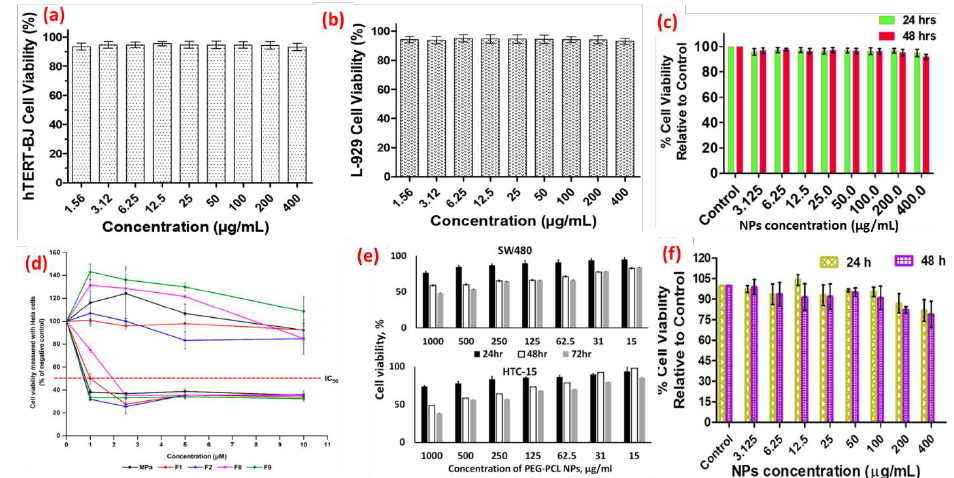
Figure 3. Safety and toxicity assessment of different nanocarriers in vitro. ( a – c ) Assessment of safety and toxicity of blank and drug-loaded chitosan NPs in dose-dependent and time-dependent manner (reproduced from [82] with permission from the American Chemical Society). ( d ) Viability of two cancer cell lines (HeLa and A549) treated with free compound and its loaded nanocarriers, F1, F2, F8, and F9 (reproduced from [84]). ( e ) Cytotoxicity analysis of PEG-PCL NPs with encapsulated Man-PEI/plasmid complexes in SW480 and HCT-15 cells, reproduced from [83]. ( f ) MTT assay for cytocompatibility of PCL-AC-gel NPs towards normal human foreskin fibroblasts (hTERT-BJ) cells (reproduced from [19] with permission from the Royal Society of